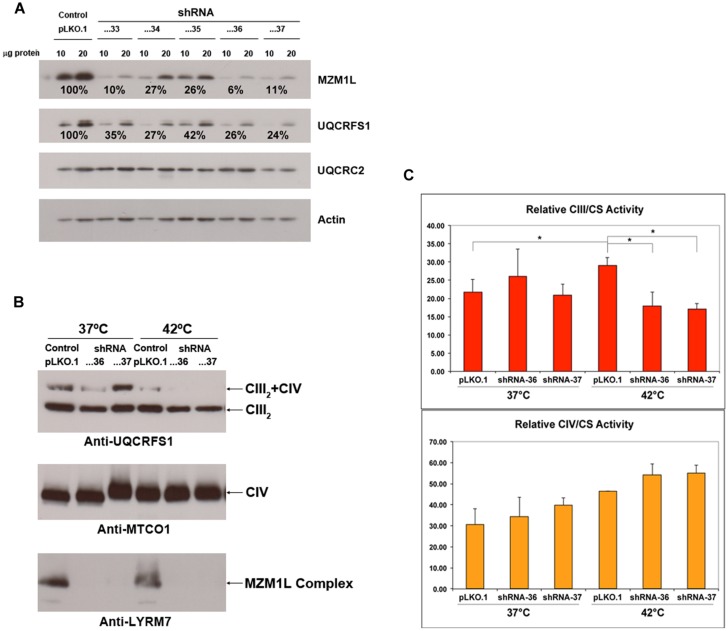
MZM1L RNA interference experiments in HeLa cells. Five different shRNA sequences cloned in the pLKO.1 lentiviral vector (TRCN0000064433-37), purchased from the MISSION® shRNA Library (Sigma-Aldrich) were stably transduced. (A) The steady state levels of the indicated proteins were quantified by SDS-PAGE, Western blot and immunodetection with specific antibodies: anti-LYRM7 (MZM1L) and Actin (Sigma-Aldrich) and UQCRFS1 and UQCRC2 (Mitosciences-Abcam). Actin was used as the normalizer/loading control. The shRNA sequences...33, …36, and …37 were the most efficient in knocking down MZM1L expression. (B) Blue-Native PAGE, Western blot and immunodetection analysis of knocked down and control digitonin-treated cells (Nijtmans et al., 2002) grown either at 37∘C or at 42∘C for 24 h. Anti-MTCO1 was from Mitosciences-Abcam. (C) Spectrophotometric CIII and CIV enzyme activities of the RNAi and control cells grown either at 37∘C or at 42∘C for 24 h. ∗p < 0.05 according to the ANOVA Post-Hoc LSD test (SPSS 16.0 software for Windows).